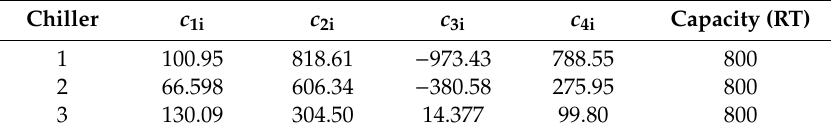
Table 3. Chiller data in case 3.